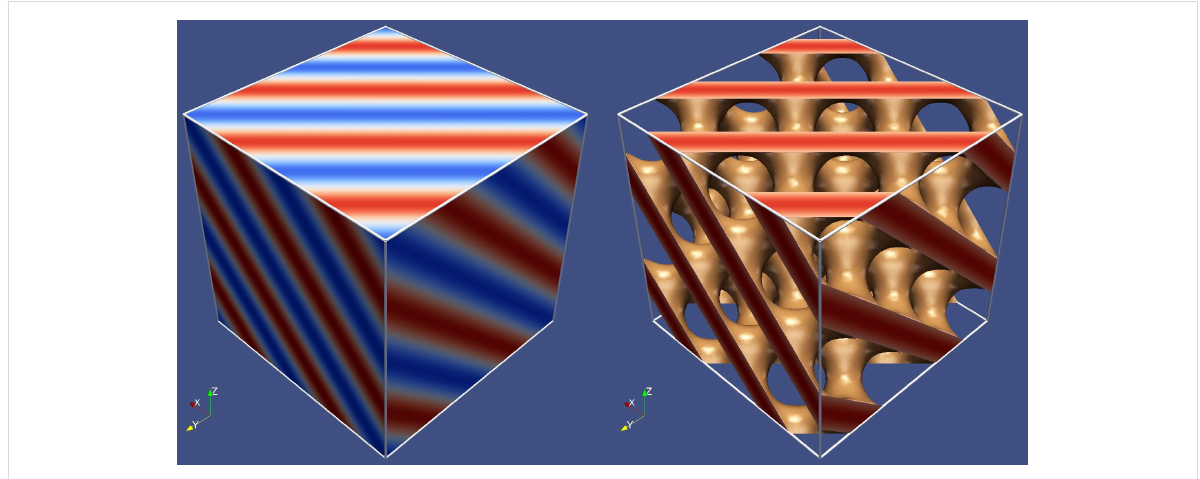
Figure 5: Ordered bicontinuous double diamond structure (space group 224), which contains two separate, connected, triply periodic, tetrahedrally coordinated networks comprised of the minority (A, "red") component in a matrix of the majority (B, "blue") component. Both the red and blue domains are three-dimensionally continuous. The right part of the figure shows the minority component bound by the isodensity